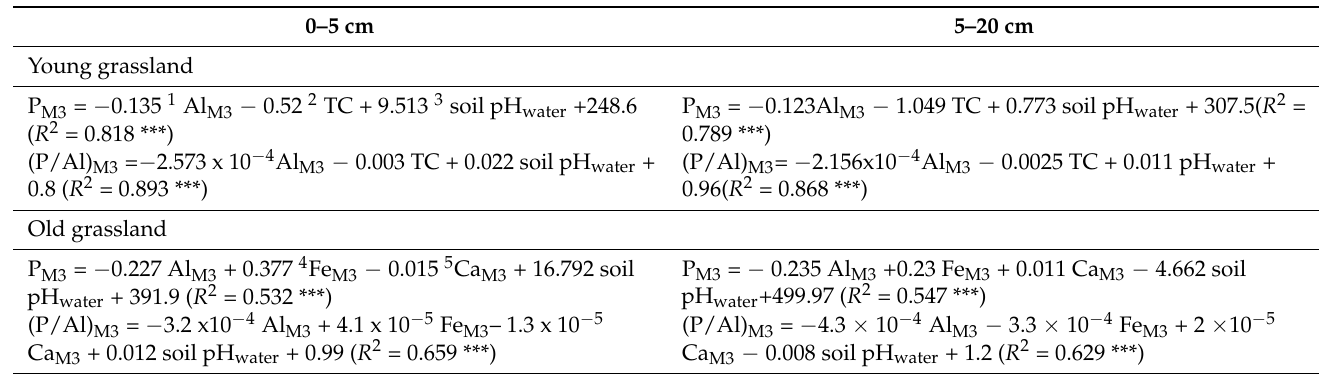
Table 4. Multiple regression equations calculated for soil P indices for two soil layers (0–5 cm and 5–20 cm) for the young and old grassland